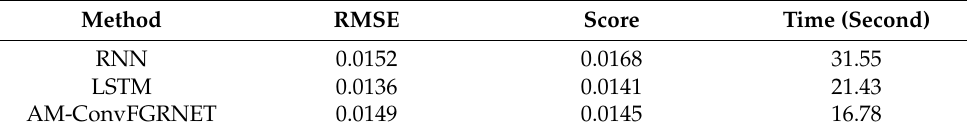
Table 13. Model performance comparison for RUL prediction based on ball screw